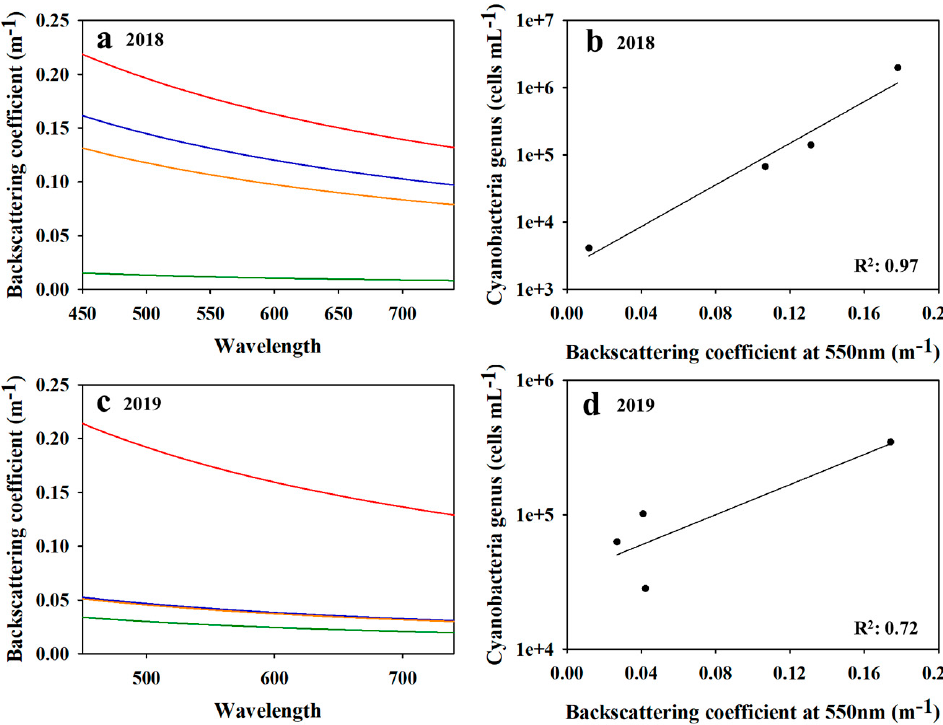
Figure 7. Backscattering coefficient spectra and the relationship between backscattering coefficient and cyanobacteria cells—( a ) is the backscattering coefficient for 26 July 2018 (blue line), 16 August 2018 (orange line), 9 September 2018 (red line), and 25 October 2018 (green line); ( b ) is the correlation between the backscattering coefficient and cyanobacteria cells at 550 nm for 2018; ( c ) is the backscattering coefficient for 9 July 2019 (blue line), 24 July 2019 (red line), 8 August 2019 (orange line), and 18 September 2019 (green line); and ( d ) is the relationship between the backscattering coefficient and cyanobacteria cells at 550 nm.